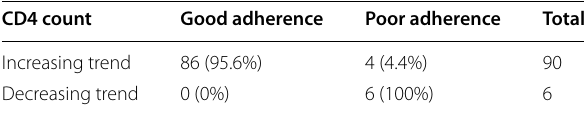
Table 4 Table showing the relationship between CD4 count